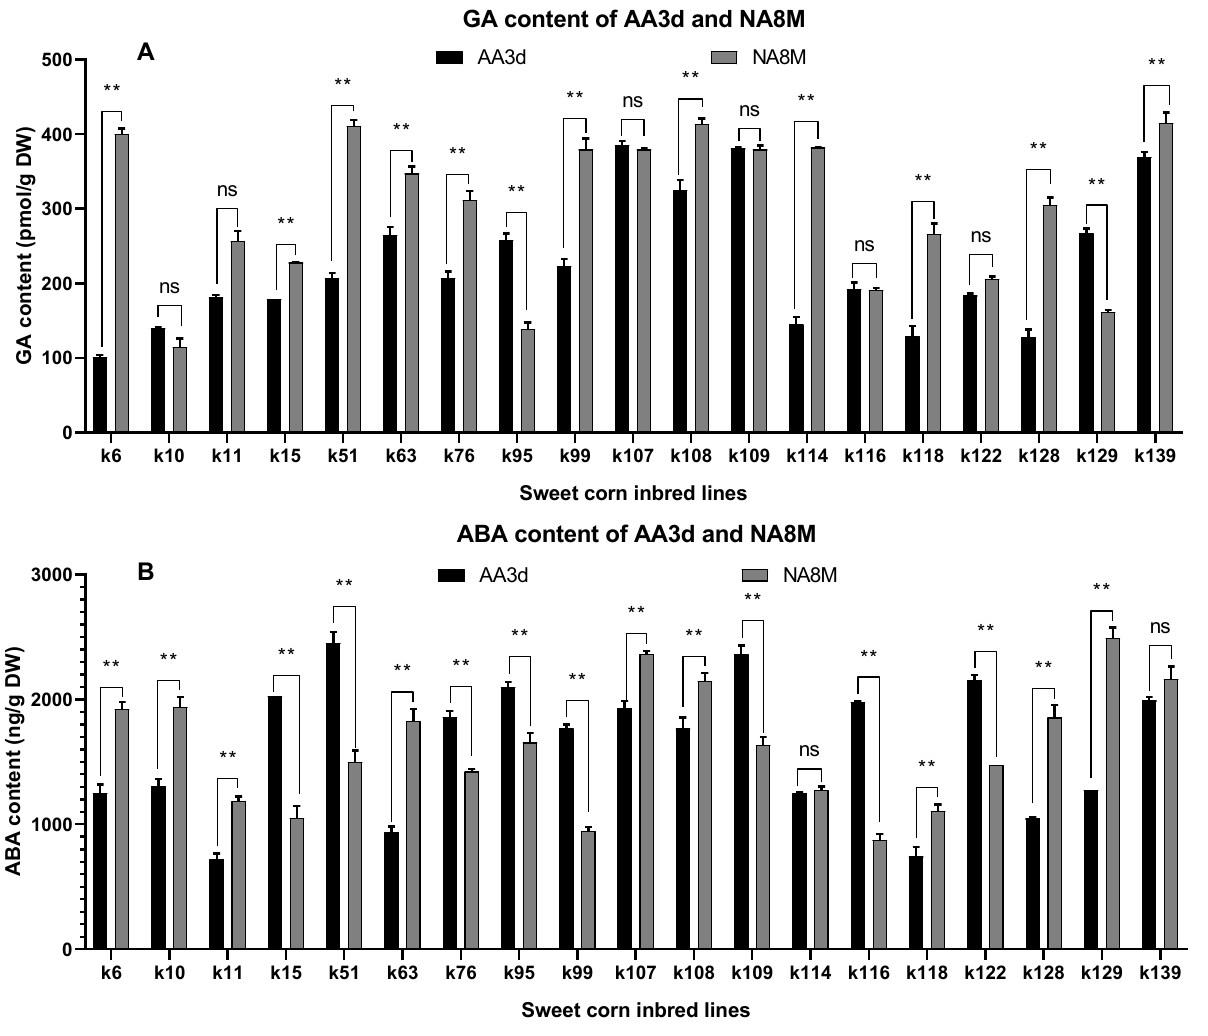
Figure 2. Comparative analysis of GA and ABA content between AA3d and NA8M seeds in 19 sweet corn lines. ( A ) GA content of AA3d- and NA8M-treated seeds. ( B ) ABA content of AA3d- and NA8M-treated seeds. ‘ns’ and ** indicate p > 0.05 and p ≤ 0.01 by t -test, respectively.